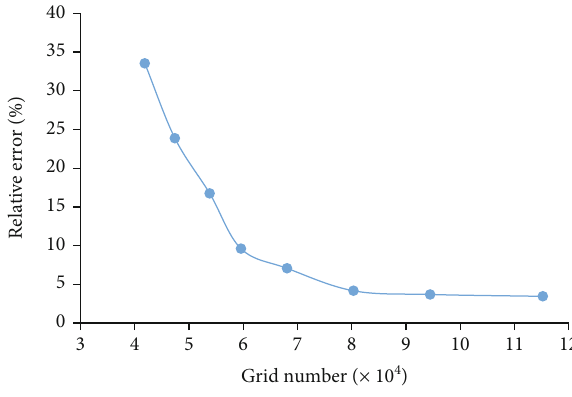
Figure 5: In fl uence of grid number on simulation accuracy.